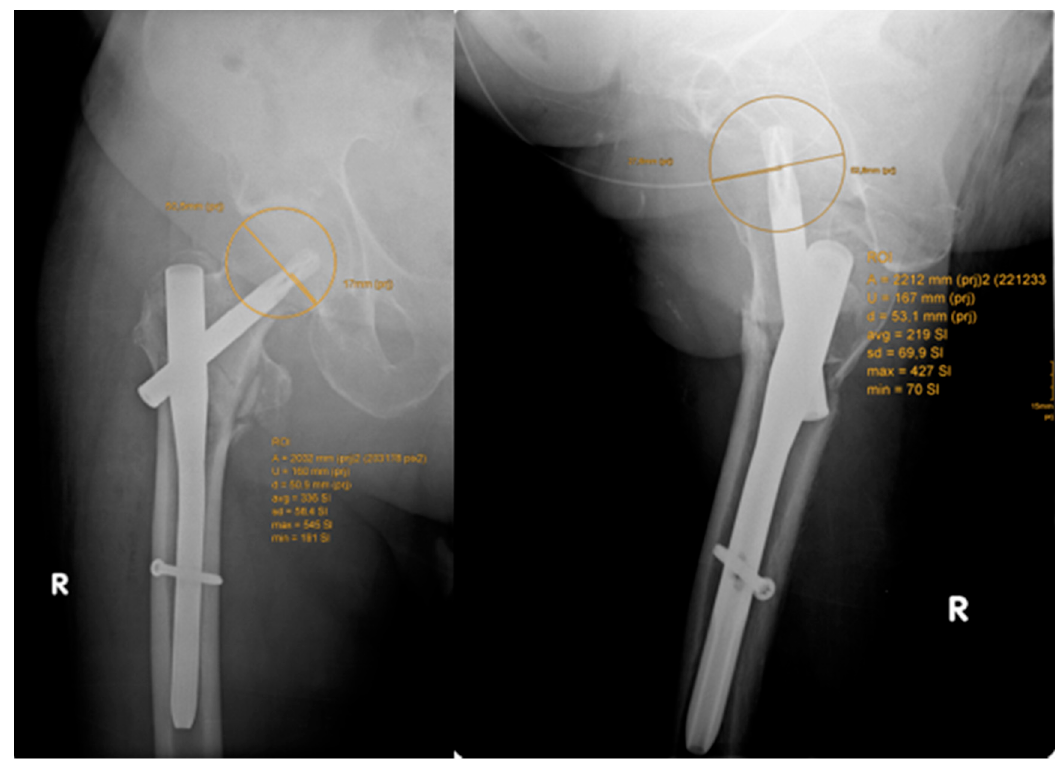
Figure 2. Assessment of the Parker’s ratio anterior–posterior view and lateral view.